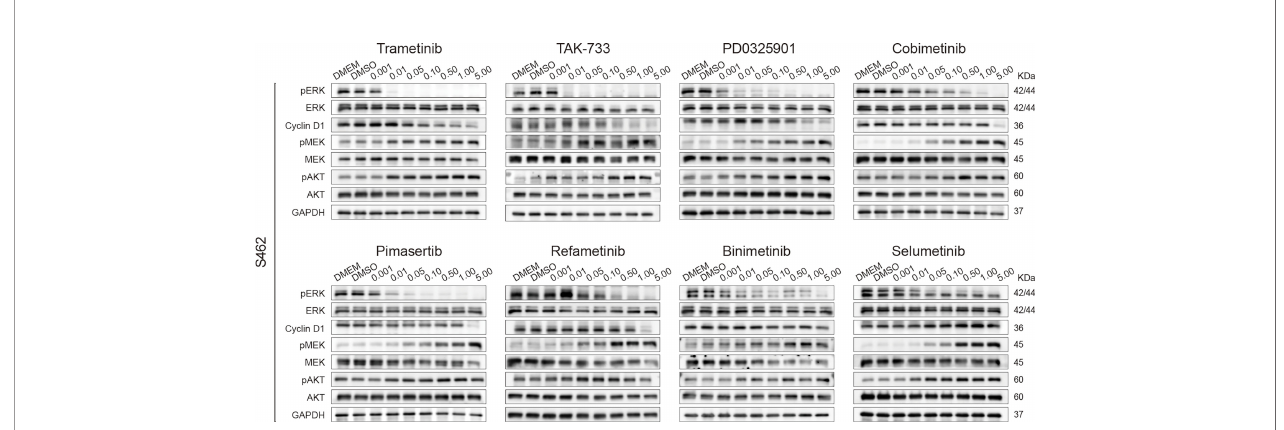
FIGURE 3 | Screening 8 MEK inhibitors in MPNST cells revealed differences in adaptive response. Expression of p-ERK, ERK, cyclin D1, p-MEK, MEK, p-AKT, AKT, and GAPDH in S462 cells treated with different MEK inhibitors at the indicated concentrations